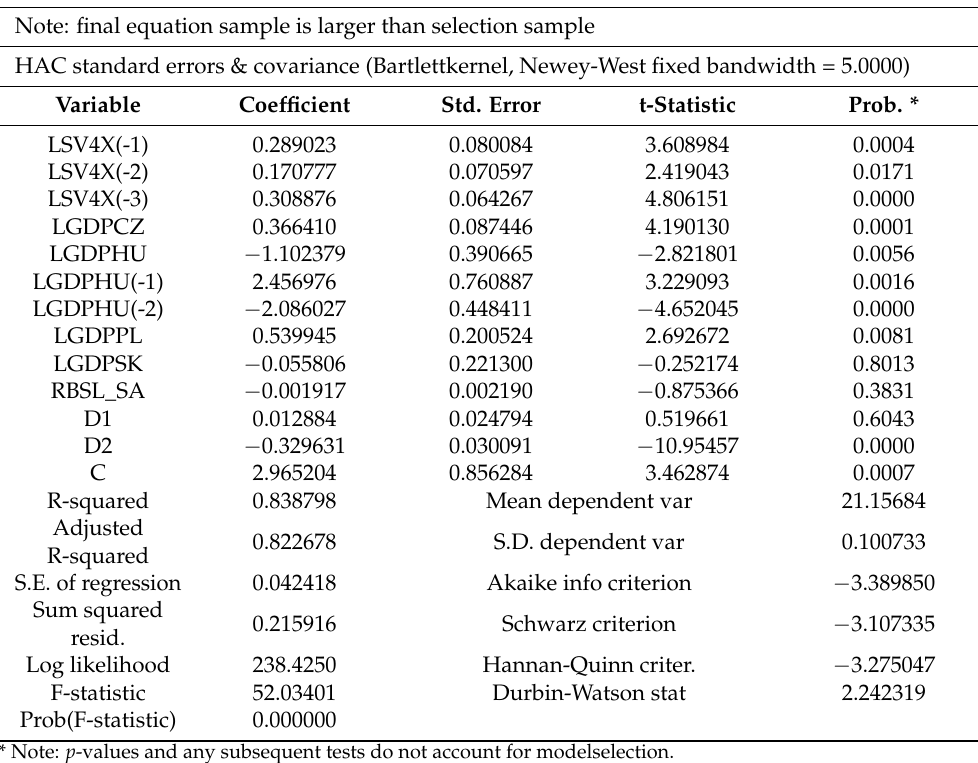
Table A4. ARDL Model for Hungary (Newey–West HAC standard errors). Selected Model: ARDL(3,0,2,0,0,0) Note: final equation sample is larger than selection